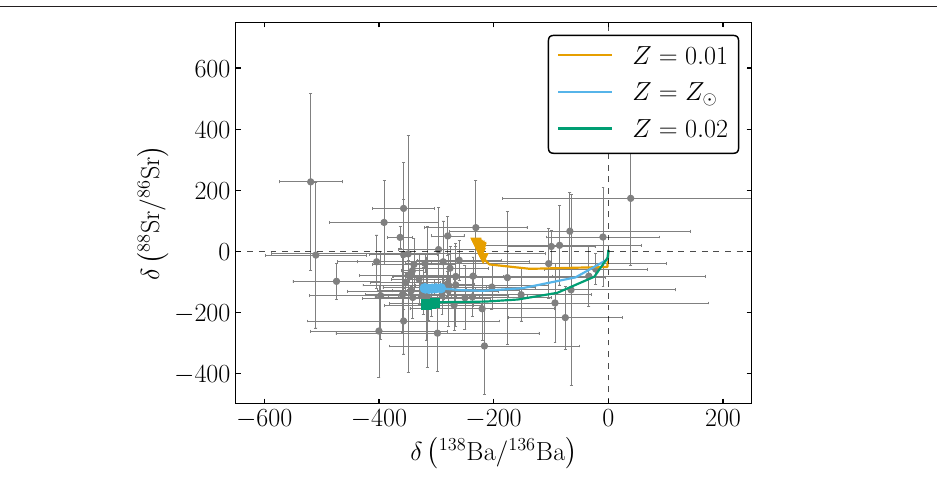
Figure 2. Comparison between FRUITY Magnetic 2 M ⊙ models at di ff erent metallicities and presolar grain isotope ratios. Isotope ratios are reported in the conventional δ notation, defined as the deviation of the ratio measured in a grain relative to the terrestrial value in parts per thousand. Grain data are from the PGD database